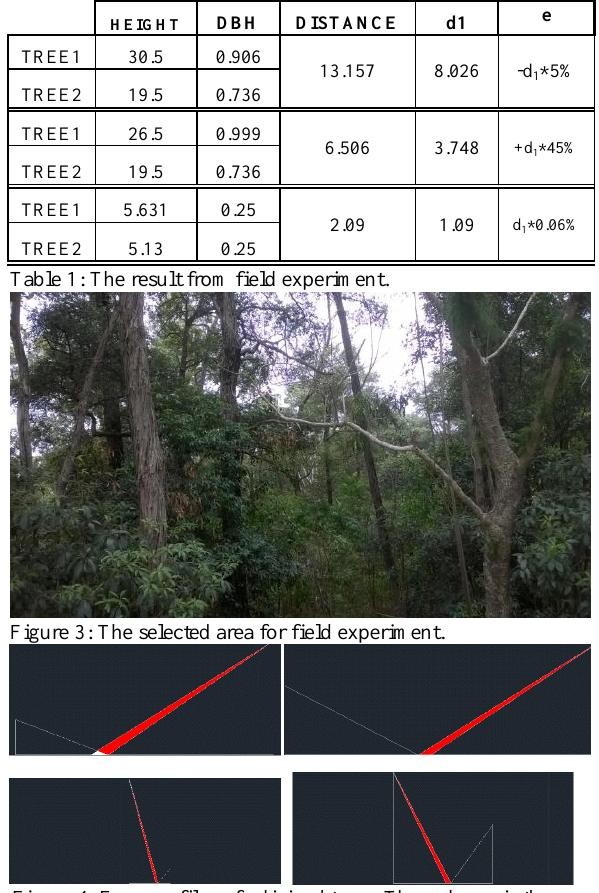
Figure 4. Four profiles of adjoined trees. The red area is the gap between the calculated depression point and the